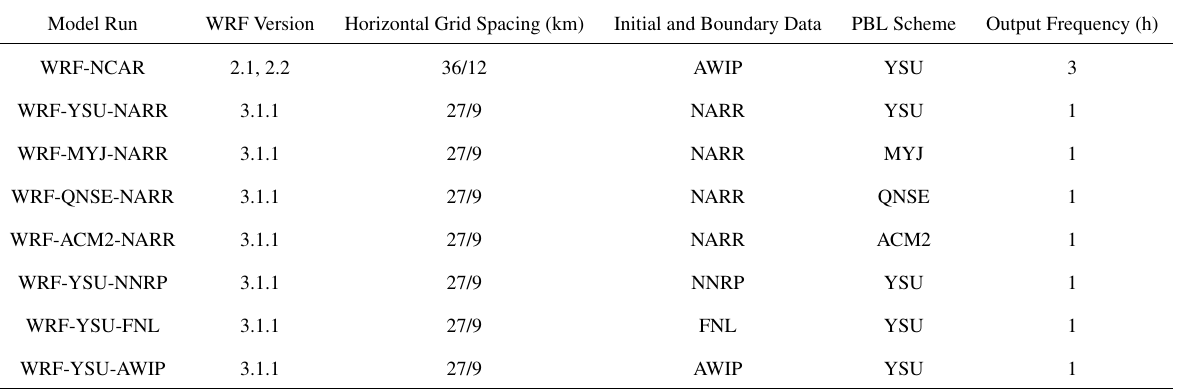
Table 2. Specifications of different WRF model